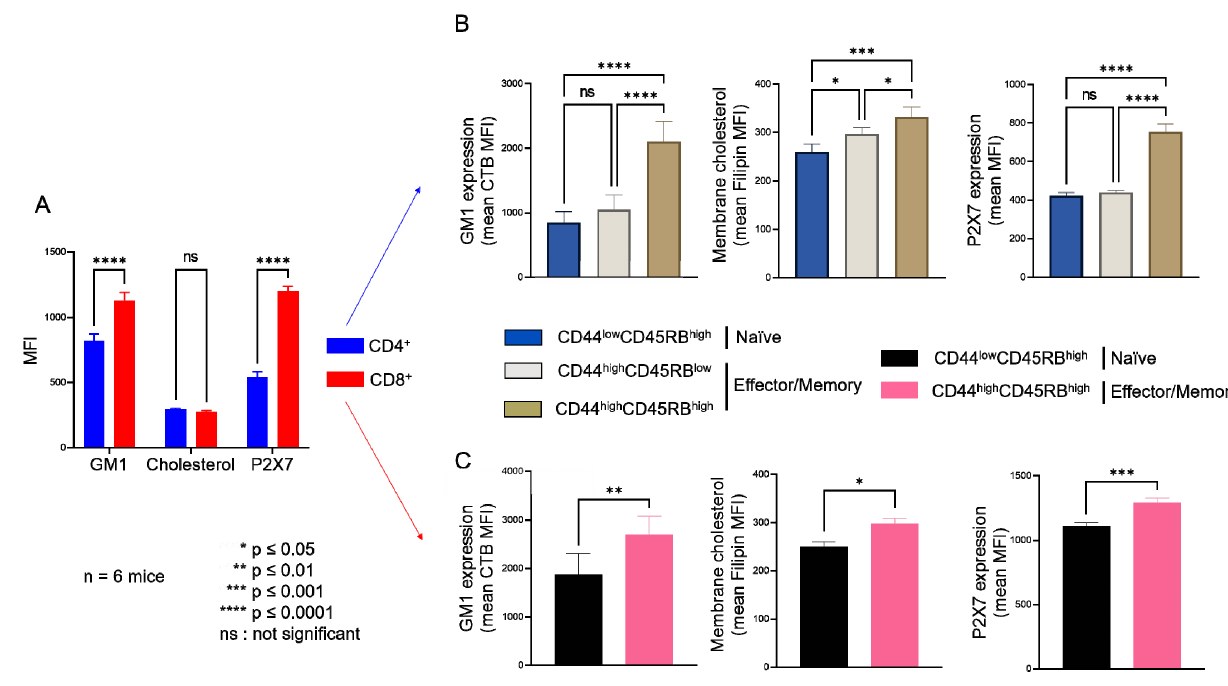
Figure 1. Plasma membrane levels of GM1 gangliosides, cholesterol and P2X7 receptor in T cells at different stages of differentiation. Plasma membrane levels of GM1, cholesterol, and P2X7 were quantified by flow cytometry using FITC-conjugated cholera toxin B subunit (CTB), filipin III, and anti-P2X7 extracellular domain mAb, respectively. Results are presented as the mean MFI values for GM1, cholesterol, and P2X7 in the CD4 + and CD8 + T-cell subpopulations ( A ) and in CD44 low CD45RB high naïve and CD44 high CD45RB low or CD44 high CD45RB high effector/memory CD4 + ( B ) and CD8 + ( C ) T-cell subsets. Data are expressed as the mean of percentages (±SEM, n ≥ 6 mice). Asterisks denote statistically significant differences * p ≤ 0.05; ** p ≤ 0.01; *** p ≤ 0.001 **** p ≤ 0.0001; ns: not